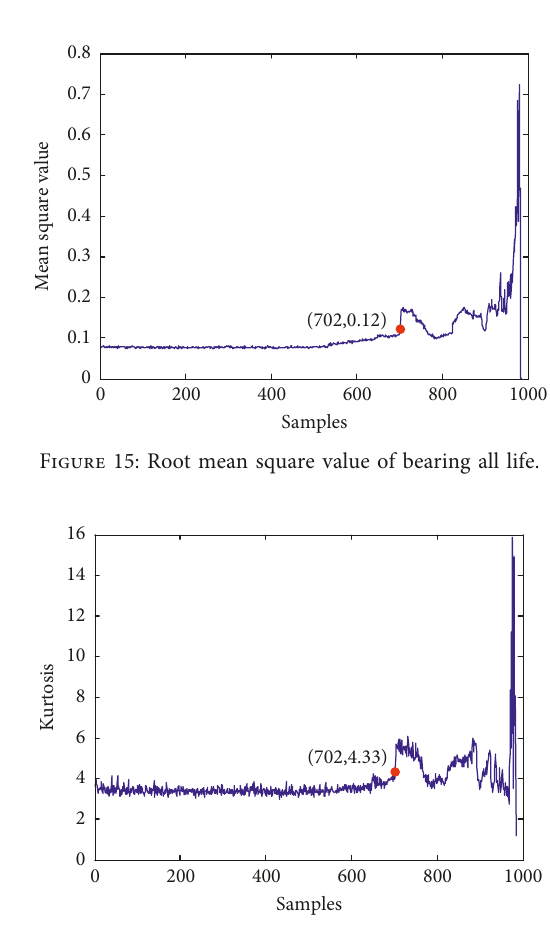
Figure 16: Kurtosis of bearing all life.